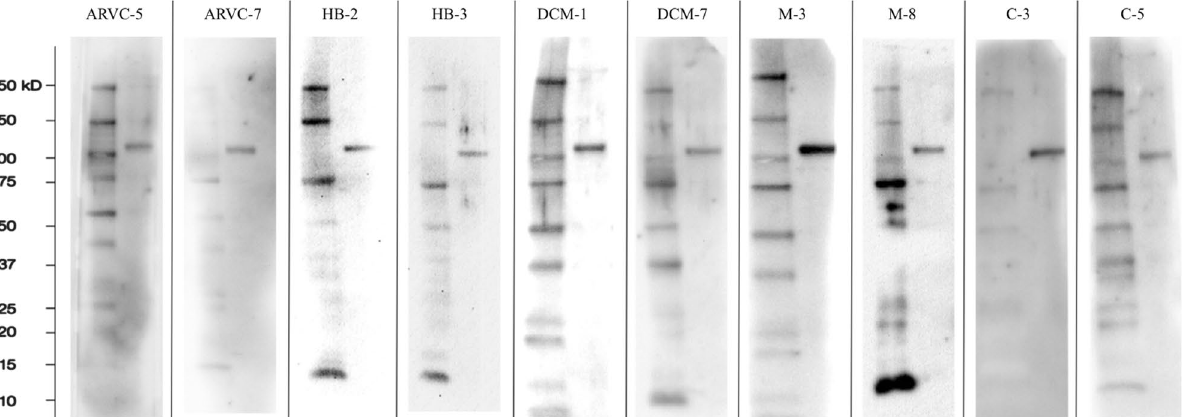
Figure 2. Representative Western blot images for two study dogs from each group, with study number above the blot. Each blot contains a molecular weight ladder in the well on the left and the desmoglein-2 band on the right at a molecular weight of 115 kDa. Blots were cut into two well sections, as above, from different gels before exposure with each individual canine serum. Western blots (cropped and uncropped) for all study dogs are displayed in Supplementary Figs. S3–S12.